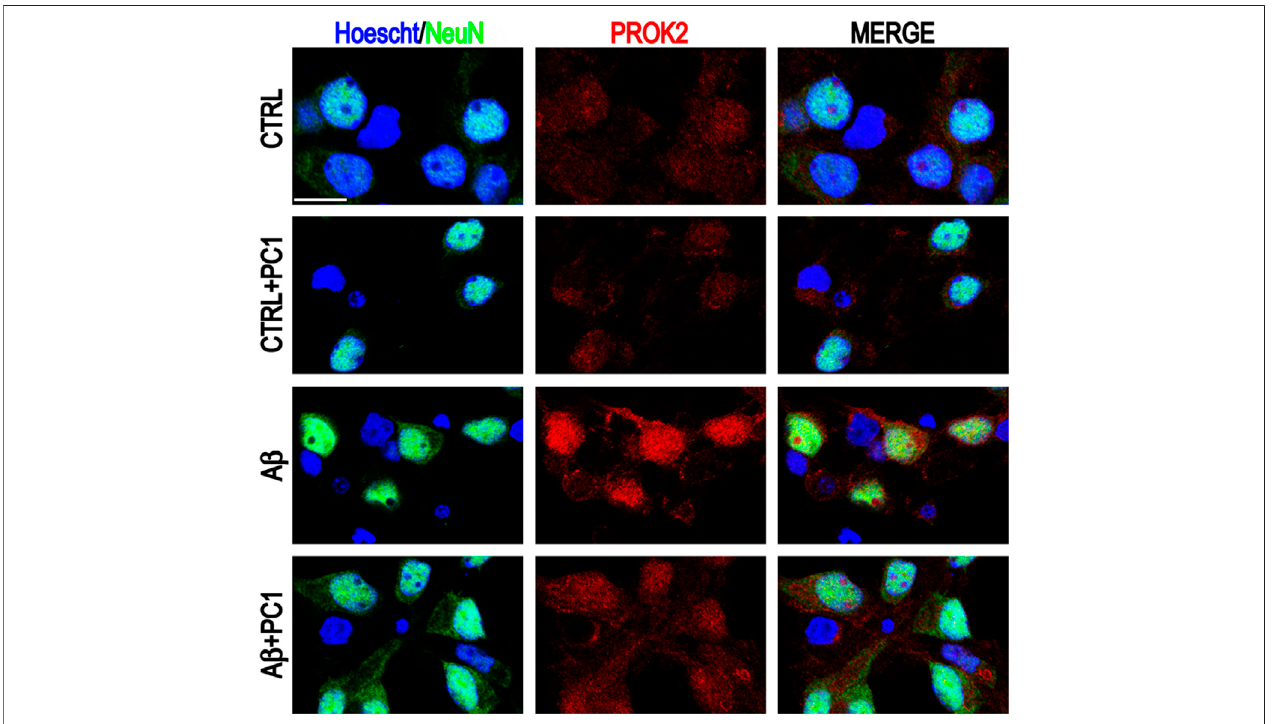
FIGURE 1 | Representative immuno fl uorescence images of cultured mixed cortical neurons (CNs) stained with anti-PROK2 antibody (red) in control conditions (CTRL) and after 48 h ofA β 1 – 42 treatment alone or in the presence ofPC1 (200 nM). Neurons were stained with NeuN (green), and nuclei with Hoecsht (blue). Scale bar: 15 μ m (Severini et al.,